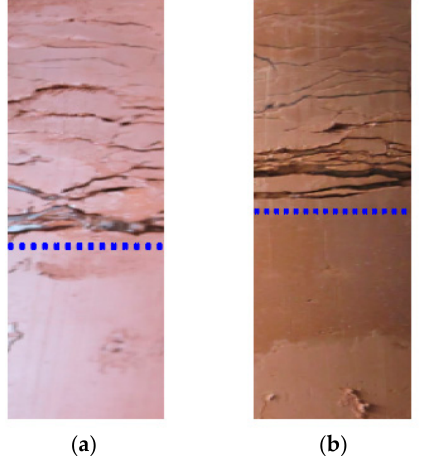
Figure 6. Ice lens distributions of soil columns at the end of Conditions I and II [19]: ( a ) Condition I with overburden pressure of 50 kPa; and ( b ) Condition II with overburden pressure of 100